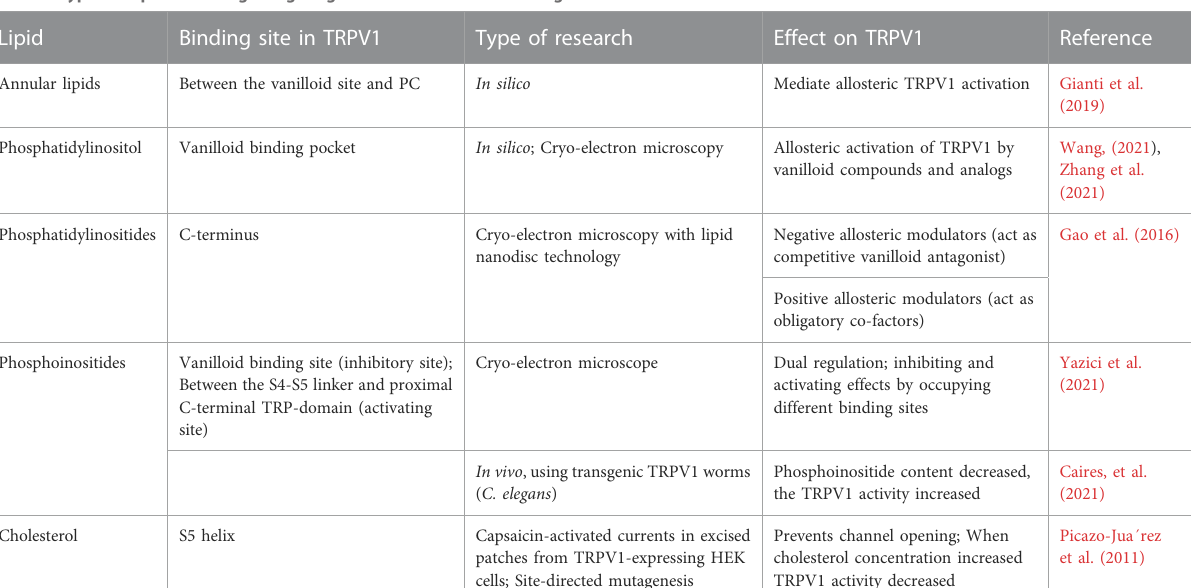
TABLE 1 Types of lipids affecting the gating of TRPV1 with their binding sites and observed